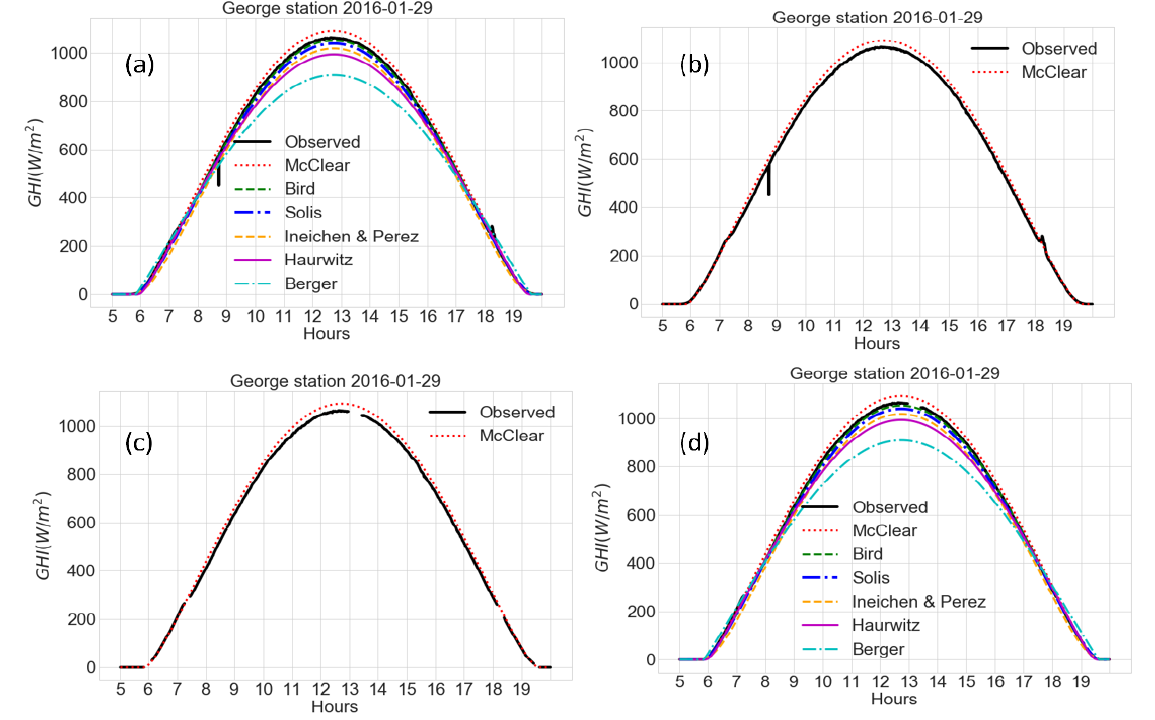
Figure 4. Illustration of Reno and Hansen methodology ( a ) Predicted irradiances with the 6 models and George station observed radiation on 29 January 2016 after only applying ERA5 reanalysis data set, ( b ) McClear and observed irradiance, ( c ) observed radiation after Reno and Hansen method is applied to detect not clear periods, ( d ) complete clear sky observed radiation and 6 clear sky models.